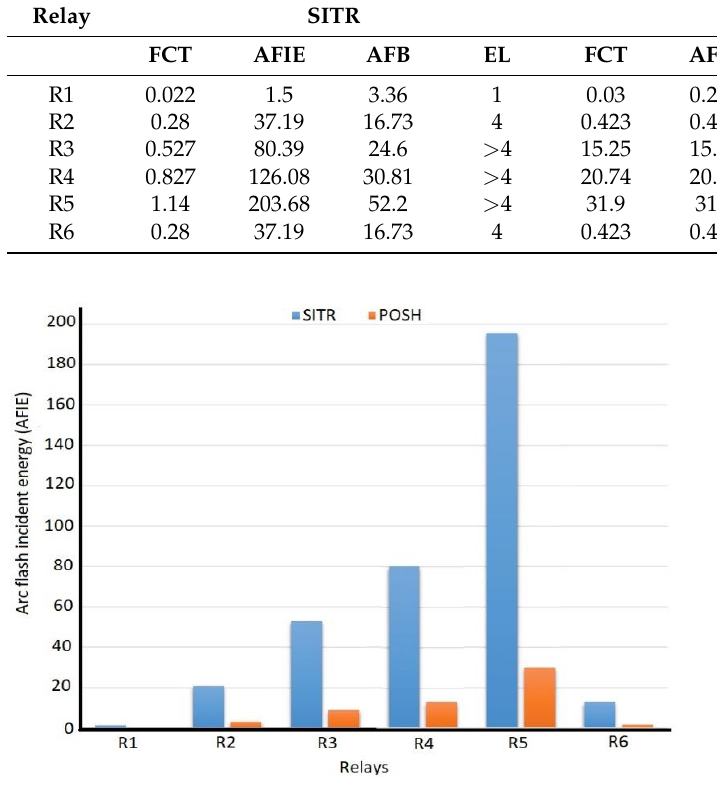
Figure 6. The AFIE during the microgrid operation modes (Mode 1 and Mode 2).